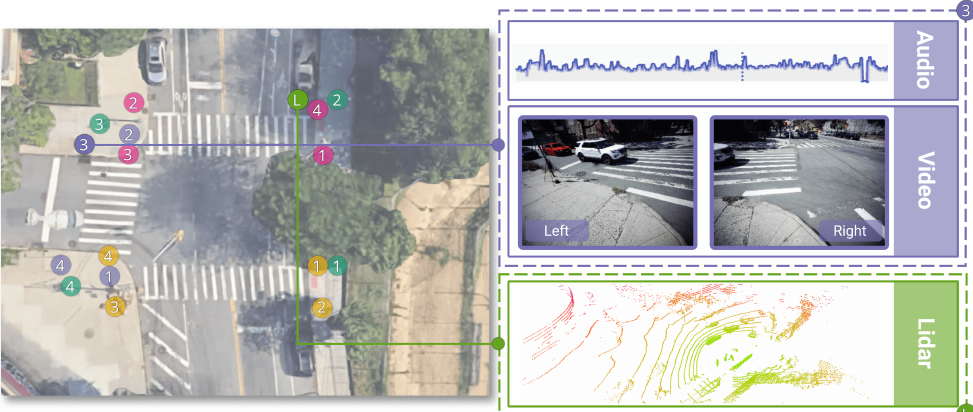
Figure 3. Illustration of the sensor positions and data types at the Commodore Barry Park intersection. Colors denote the different recording sessions, and numbers indicate the REIP sensors. This figure highlights all data modalities that are being captured during the collection process: audio, video, and LiDAR scans. Green L indicates the LiDAR sensor position fixed for all recording